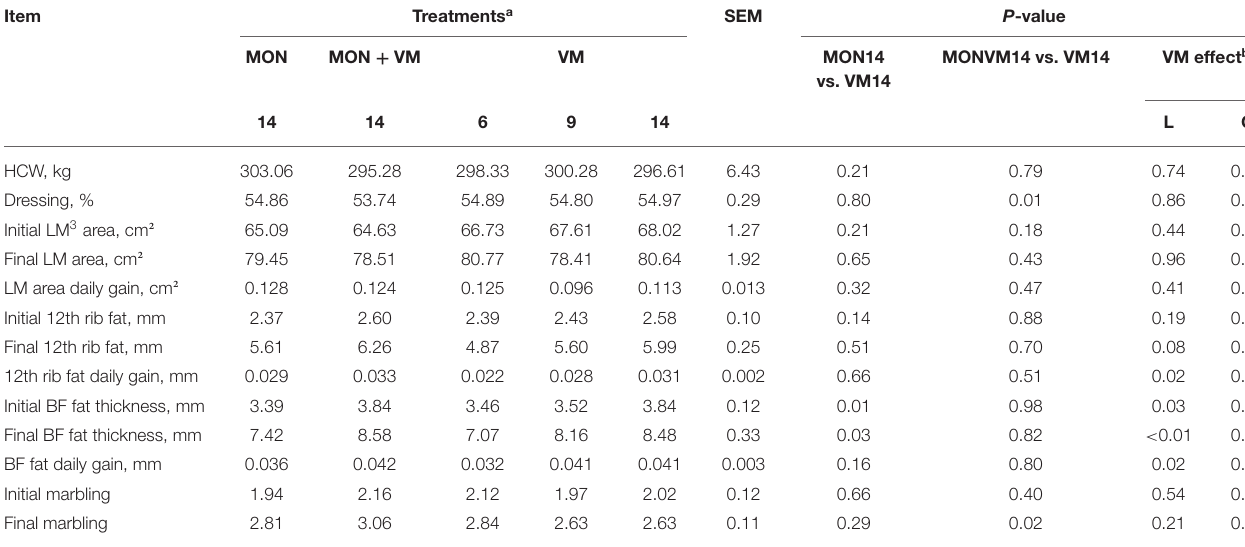
TABLE 5 | Carcass traits of Nellore yearling bulls consuming high-concentrate diets containing sodium monensin (MON), virginiamycin (VM), or both during the adaptation and finishing periods. Item